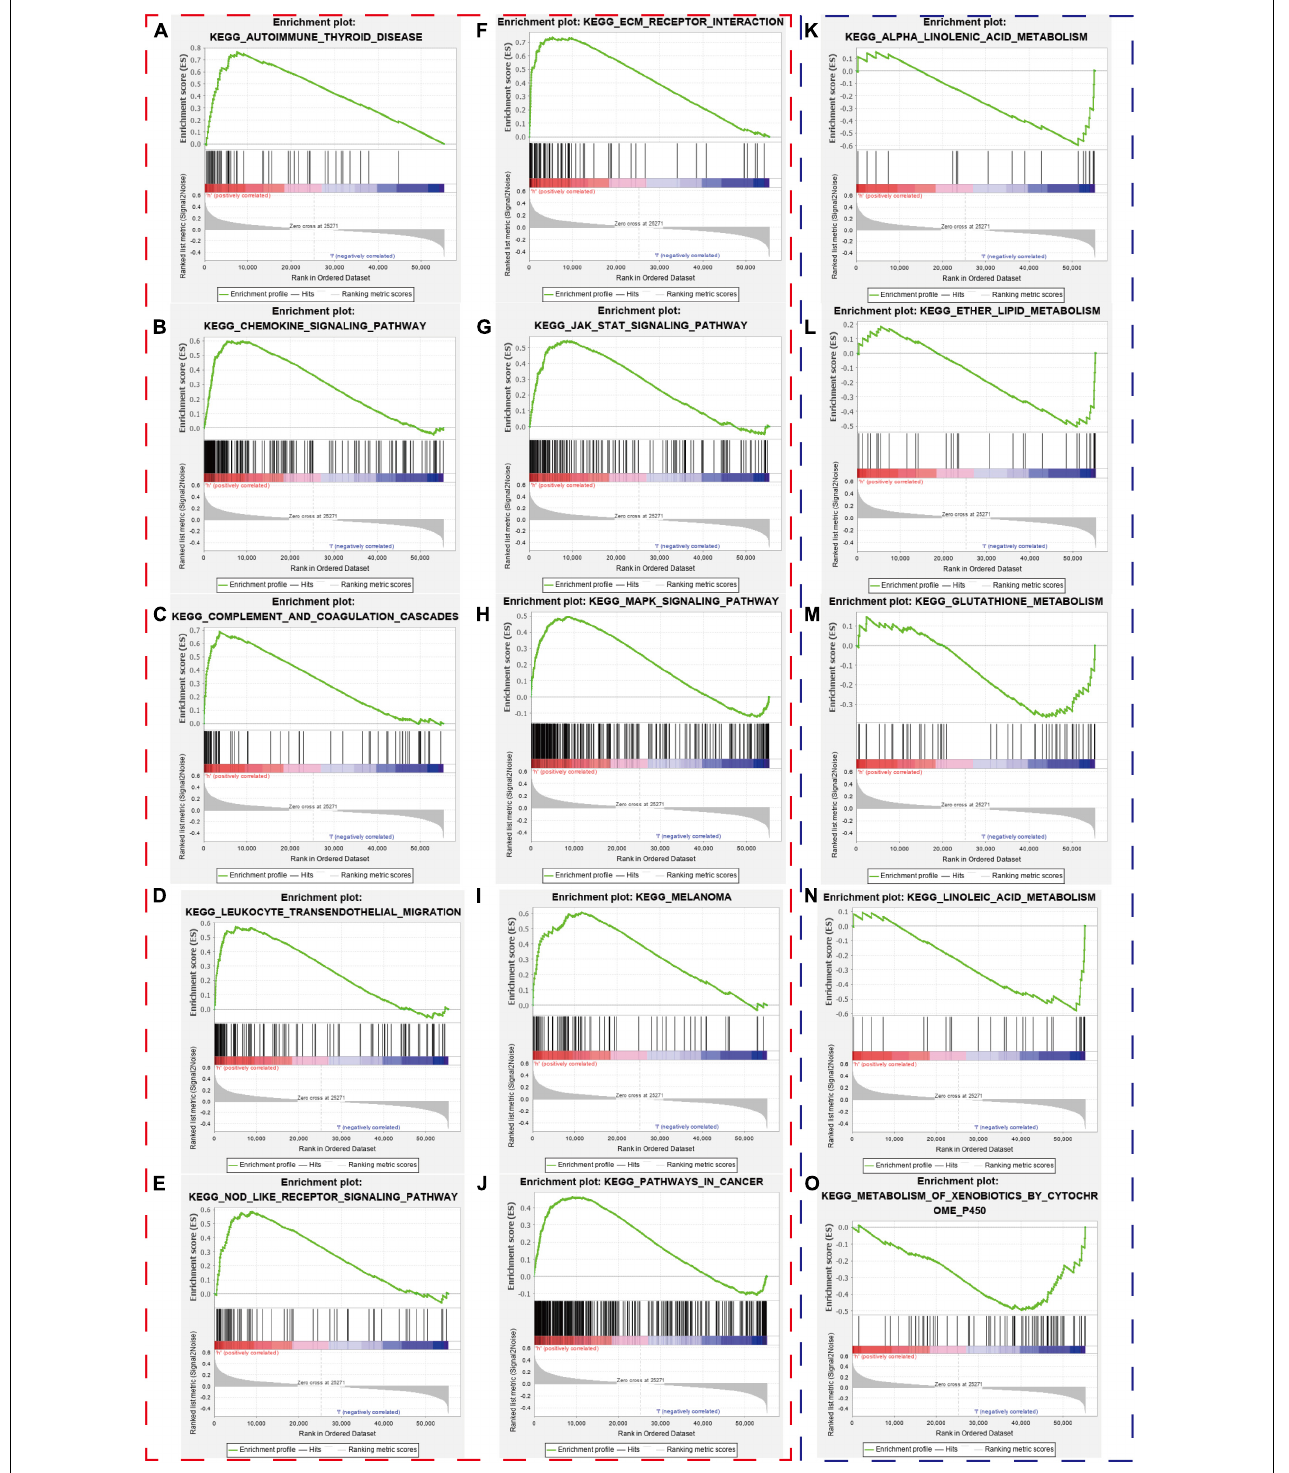
FIGURE 11 | Gene-set enrichment analysis. The red and blue dashed boxes corresponded to high- and low-risk groups. GSEA results showed significant enrichment of immune- and cancer-related signaling pathways in the high-risk group (A–J) , and significant enrichment of metabolism signaling pathways in the low-risk group (K–O)